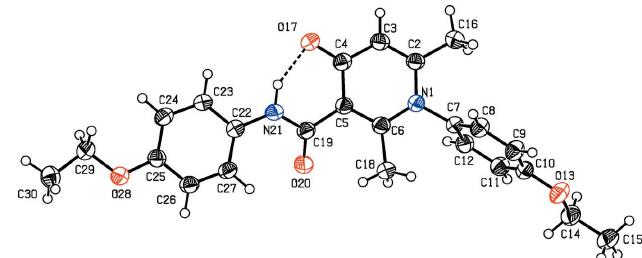
Figure 1 Perspective view of the title compound. Displacement ellipsoids are drawn at the 50% probability level. The intramolecular hydrogen bond is drawn with a dashed line.